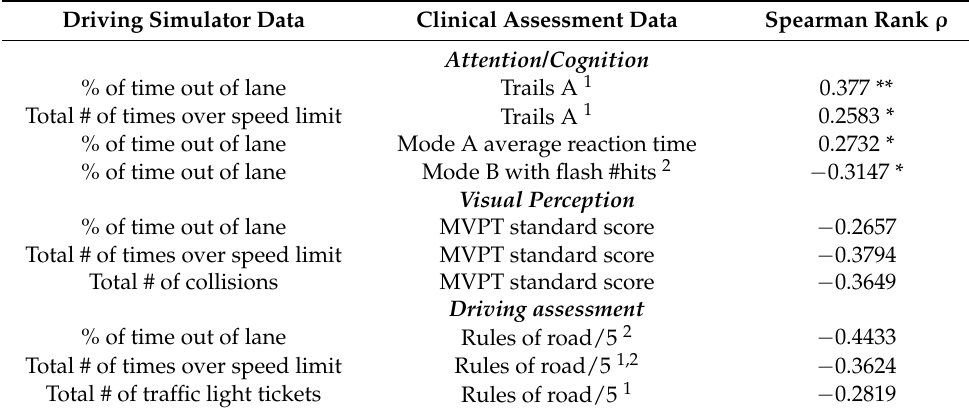
Table 5. Correlations between simulator data and Clinical assessment